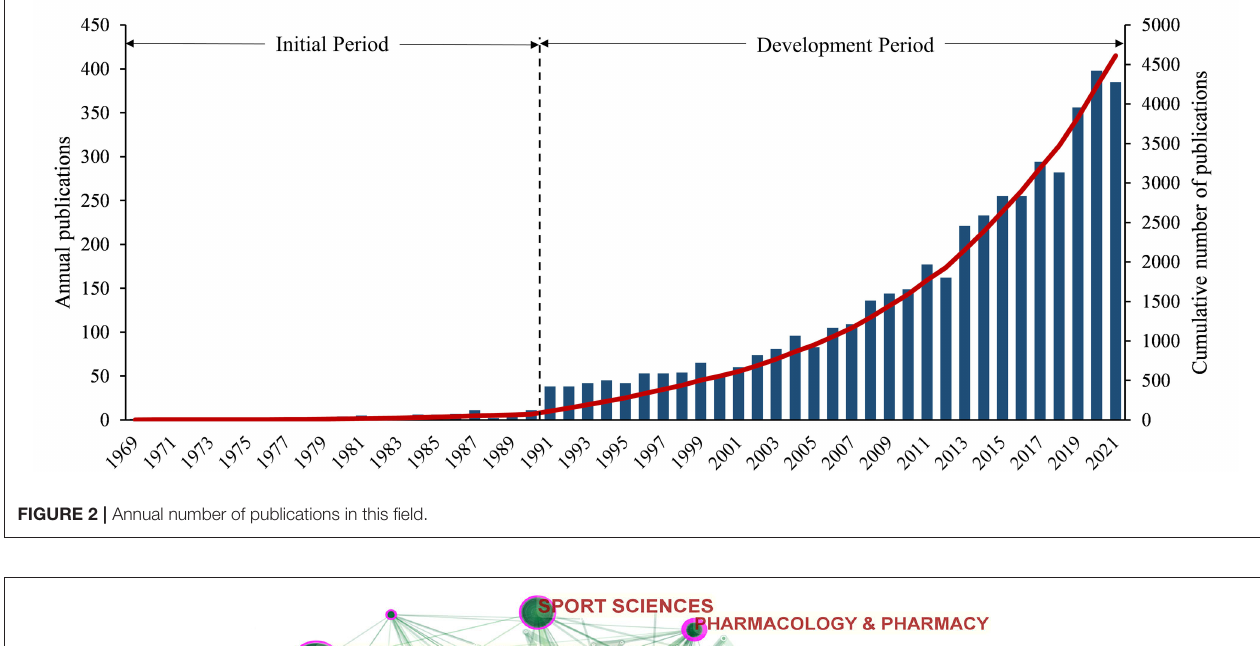
FIGURE 2 | Annual number of publications in this field.